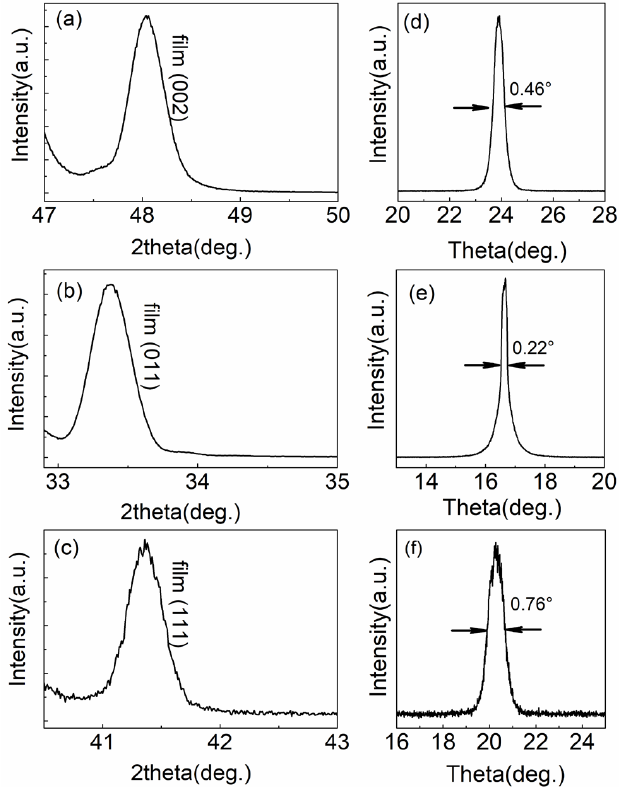
Figure 5. ( a – c ) The XRD θ /2 θ symmetric scans for LSCO thin films grown on (001) SrTiO 3 , (011) SrTiO 3 , and (111) SrTiO 3 substrates, respectively. ( d – f ) The rocking curves of Bragg peaks in Figure 5 a – c , respectively. The arrows indicate the location and full width of the rocking curves at half